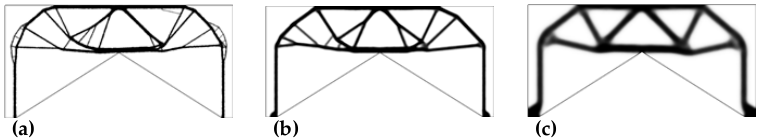
Figure 14. Optimal topologies using various filter radii for a portal frame: ( a ) filter radius R = 0.013 ( f = 0.135), ( b ) filter radius R = 0.033 ( f = 0.168), ( c ) filter radius R = 0.08 ( f = 0.240).